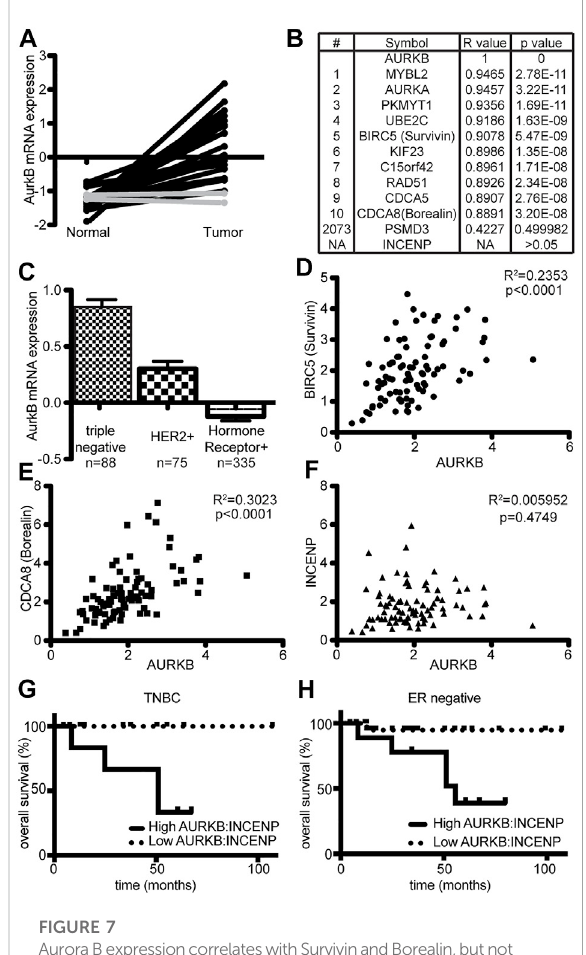
FIGURE 7 AuroraBexpressioncorrelateswithSurvivinandBorealin,butnot INCENP, in breast cancer. Analysis of TCGA breast cancer data (Network, 2012). (A) Analysis of AURKB (Aurora B) mRNA expression levelsin22matchedpairsofnormalandcancerousbreasttissue. LinesconnectdotsdisplayingtheAURKBexpressionlevelinmatching tissue. In 20 of 22 cases, expression of AURKB mRNA is substantially higher in tumor tissue than in matched normal breast tissue (black). Theothertwocasesareshowningray. (B) PavlidisTemplateMatching